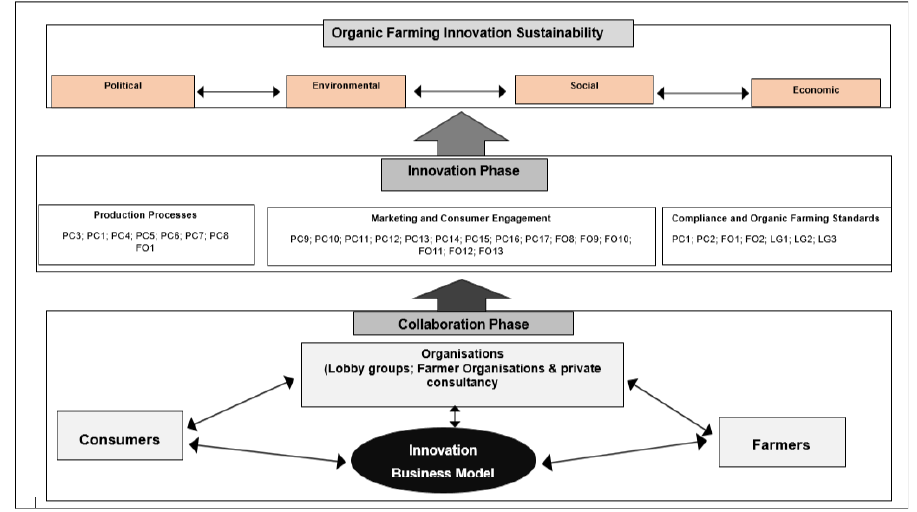
Figure 1: A framework of classification of innovative practices. Source: Krishnan et al.